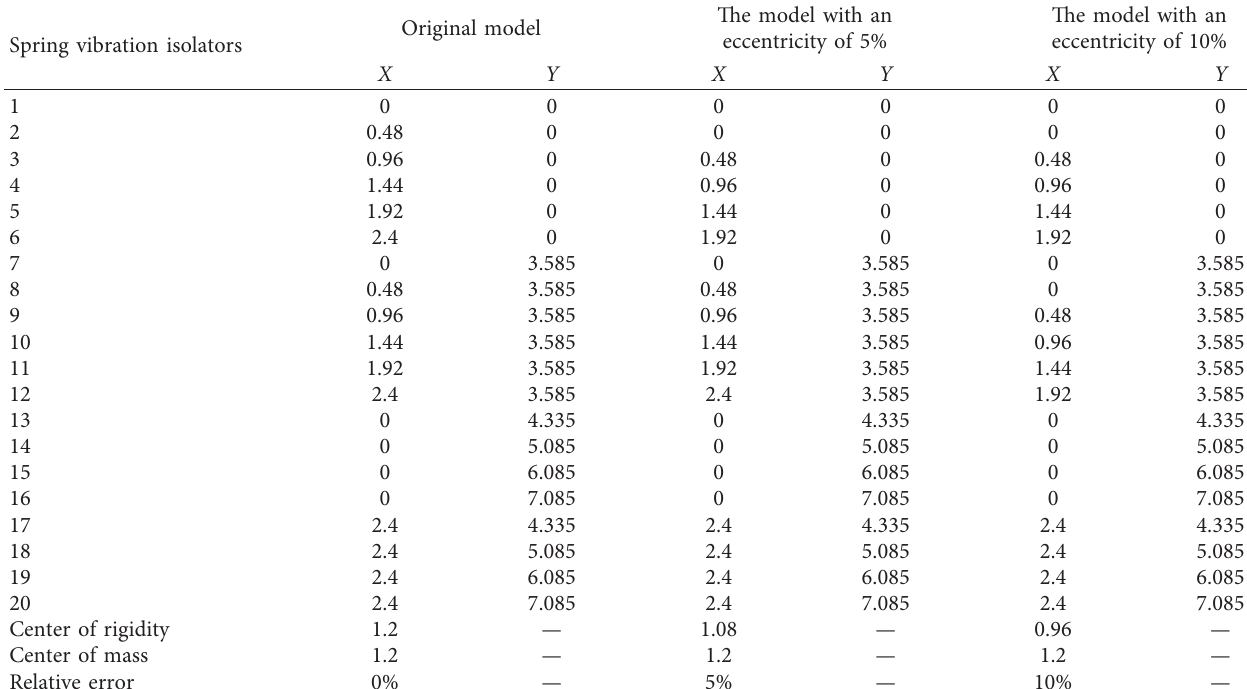
Table 10: Positions of spring vibration isolators in